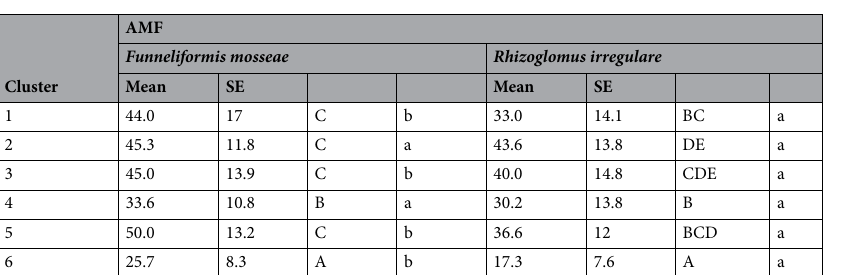
Table 2. Percentage of colonized root length of tetraploid wheats (means and standard errors, SE), by arbuscular mycorrhizal fungus (AMF) and genetic clusters. Means followed by the same letter do not differ significantly (P < 0.05). Capital letters (in columns) refer to differences among clusters within Funneliformis mosseae or Rhizoglomus irregulare treatments. Small letters (in rows) refer to differences between AMF within a cluster. Simple effect test with Sidak correction.